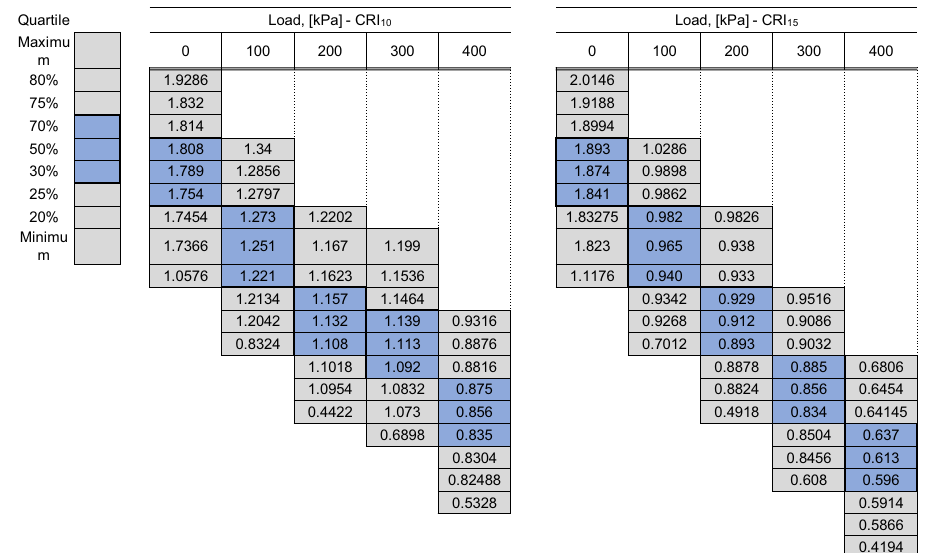
Table 1. Distributions of cooling rate index. The blue color corresponds with quantiles in the range of 20–80%.